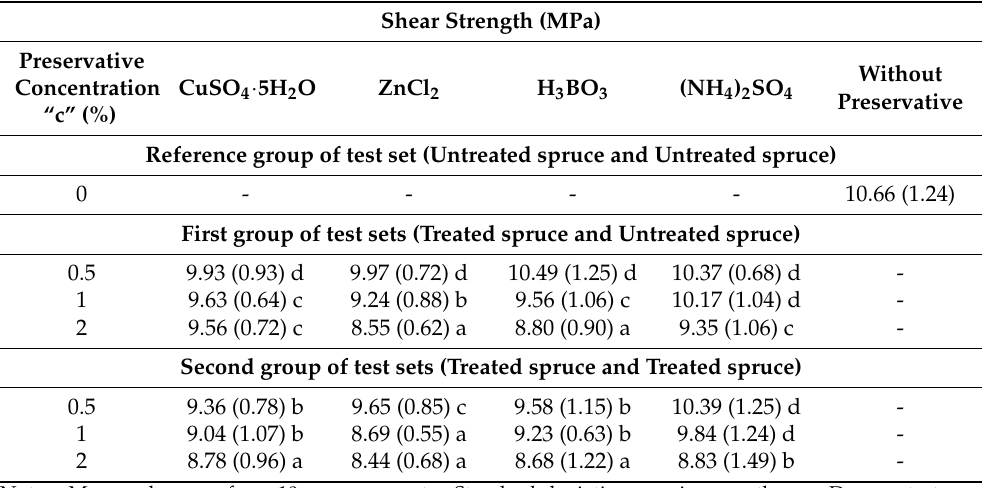
Table 2. Shear strength of joints in the reference (control) set and the test sets—formed from two spruce wood specimens (untreated or treated with inorganic preservative) and PUR